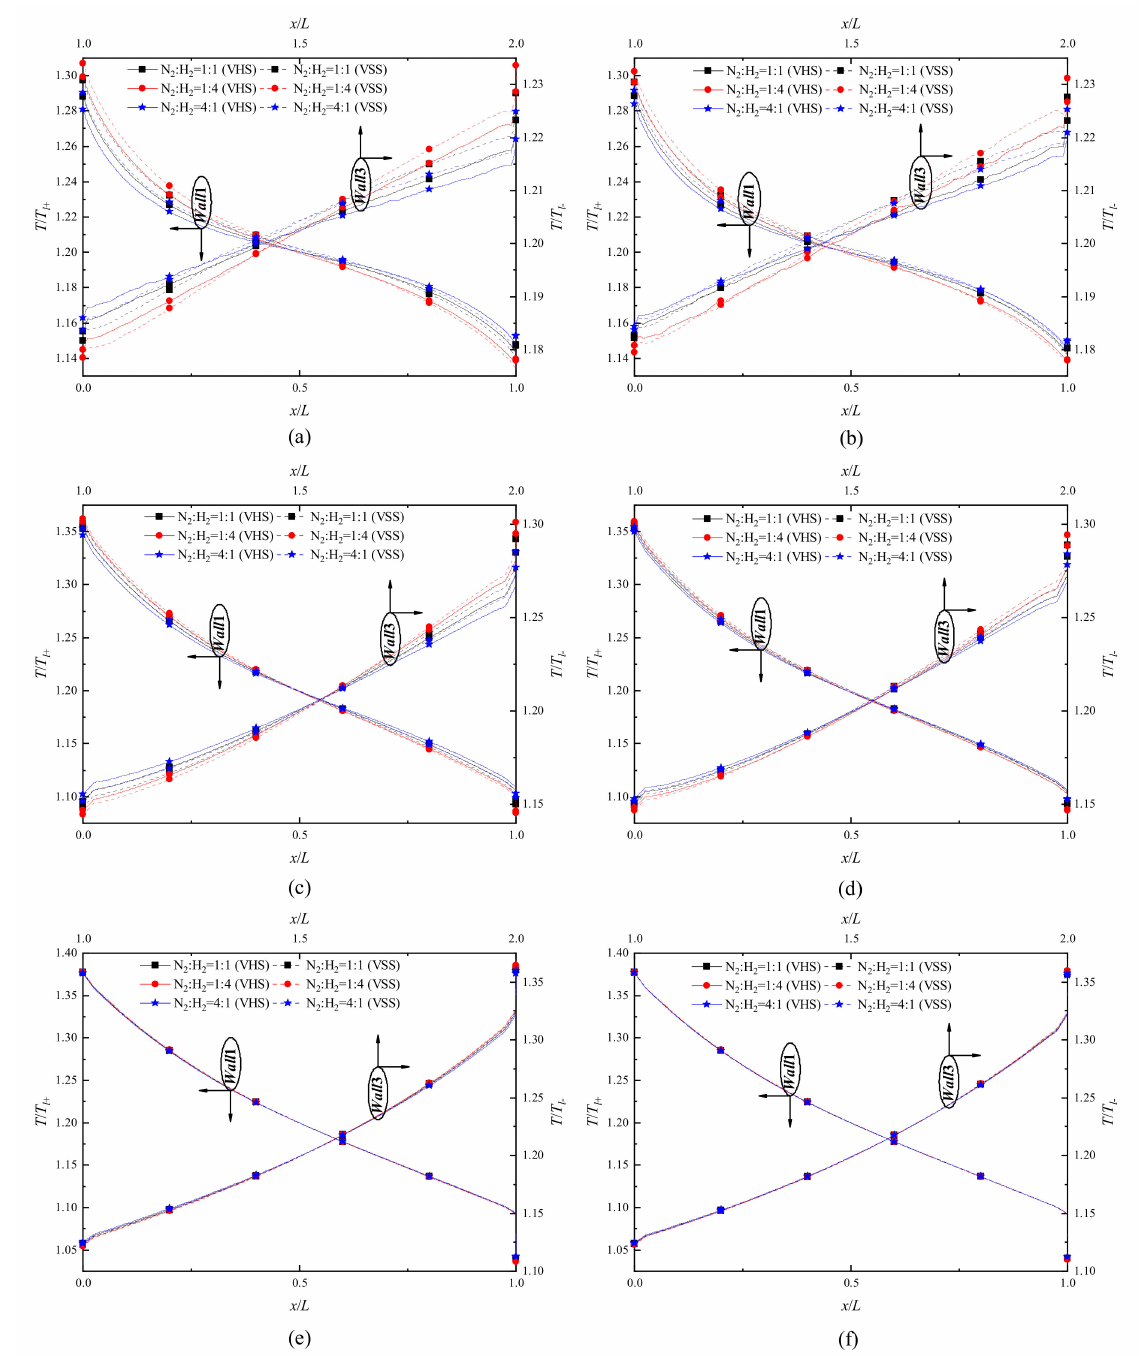
Figure 3. Temperature jump distributions of H 2 and N 2 on the Wall 1 and Wall 3 surfaces for di ff erent pressures. ( a ) P = 71.495 kPa, gas species: H 2 , ( b ) P = 71.495 kPa, gas species: N 2 , ( c ) P = 14.3 kPa, gas species: H 2 , ( d ) P = 14.3 kPa, gas species: N 2 , ( e ) P = 1.43 kPa, gas species: H 2 , ( f ) P = 1.43 kPa, gas species: N 2